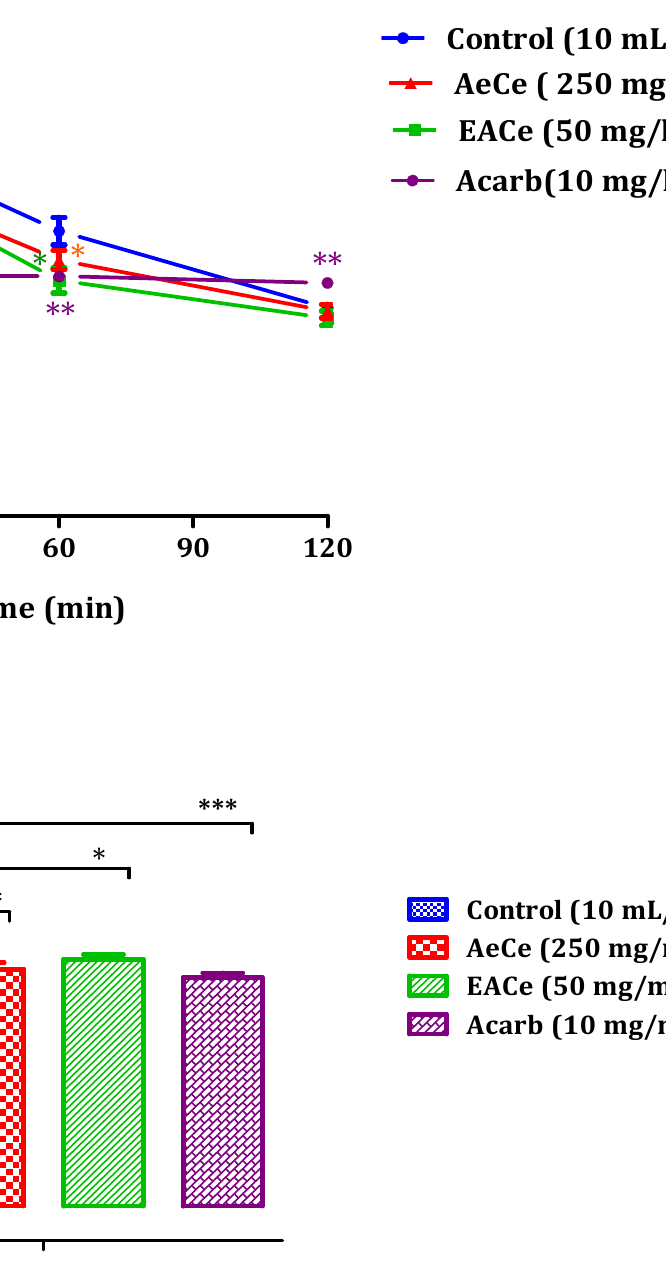
Figure 6. Effect of AeCe, EACe, and acarbose on plasma glucose levels after starch intake in normal rats ( A ), with a representation of the area under the curves ( B ). The values are the means ± SEM ( n = 6). * p < 0.05, ** p < 0.01, and *** p < 0.001 compared to the control group.